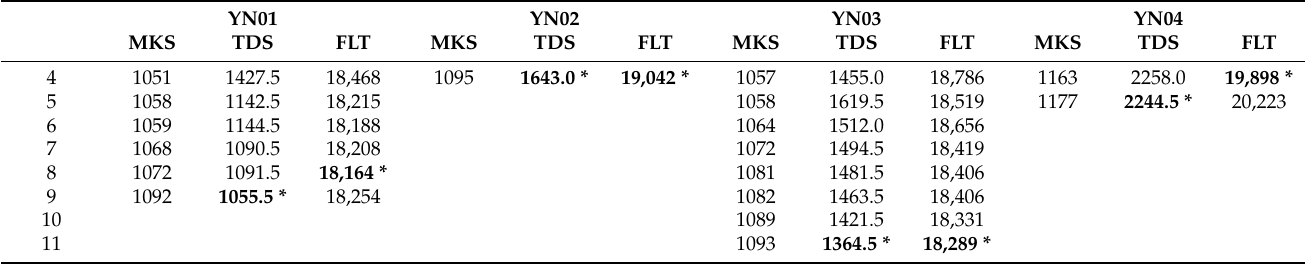
Table A20. Non-dominated solutions obtained by SS/CMOTA for the JSSP instances proposed by [38].